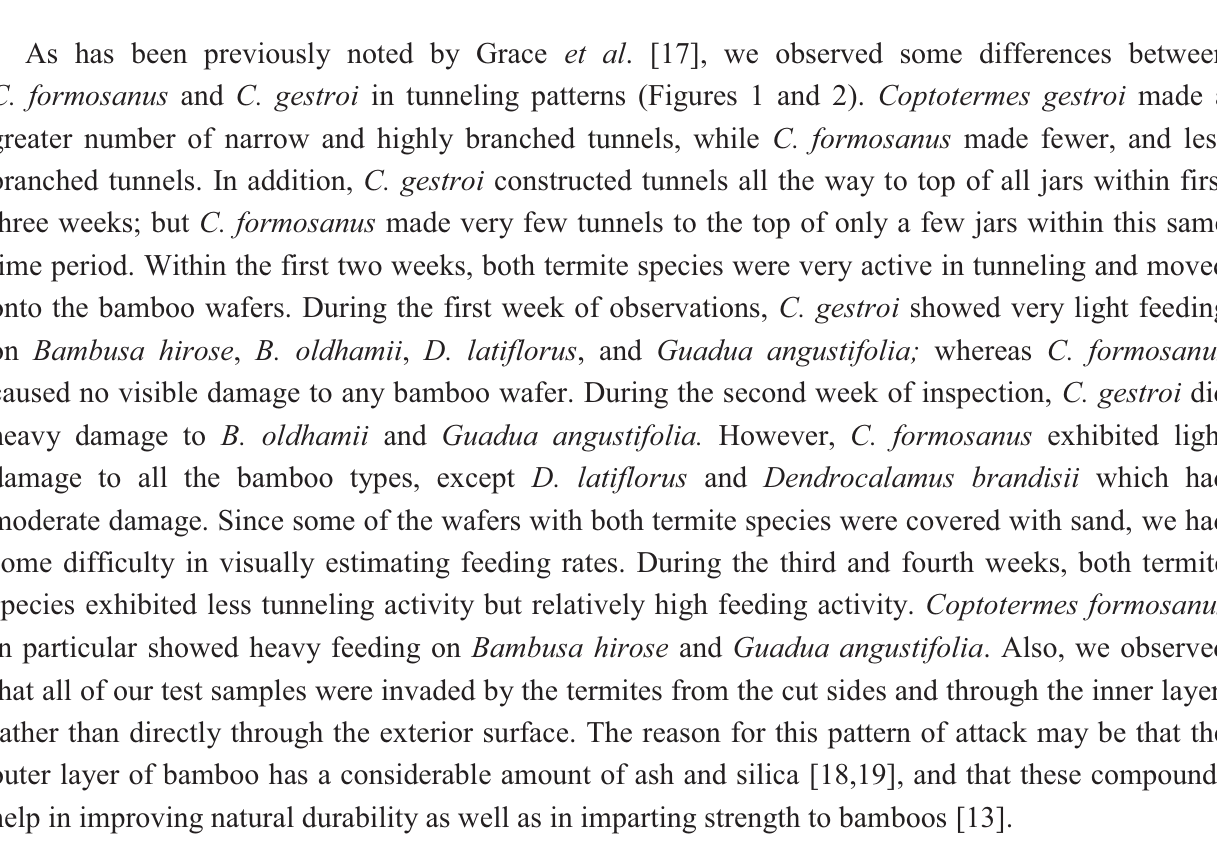
Figure 1. Sample test jars of C. formosanus ( left ) and C. gestroi ( right